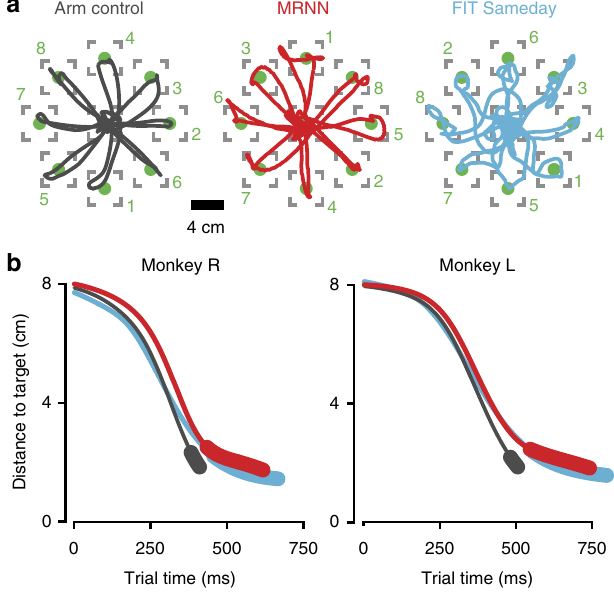
Figure 5 | MRNN achieves high-performance under ‘ideal’ conditions. ( a ) We compared cursor control using the MRNN (red) trained from many data sets up through the previous day to the FIT Sameday (blue) trained from data collected earlier the same day, without any artificial challenges (that is, no electrodes dropped or stale training data). Cursor trajectories are shown for eight representative and consecutive centre-out-and-back trials of the Radial 8 Task. Grey boxes show the target acquisition area boundaries, and the order of target presentation is denoted with green numbers. For comparison, cursor trajectories under arm control are shown in grey. From dataset R.2014.04.03. ( b ) Mean distance to target, across all Radial 8 Task trials under these favourable conditions, as a function of trial time using each cursor-control mode. Thickened portions of each trace correspond to ‘dial-in time’, that is, the mean time between the first target acquisition and the final target acquisition. These MRNN and FIT Sameday data correspond to the drop 0 electrodes condition data in Fig. 3, and include 4,094 (3,278) MRNN trials and 4119 (3,305) FIT Sameday trials over 9 (8) experimental days in Monkey R